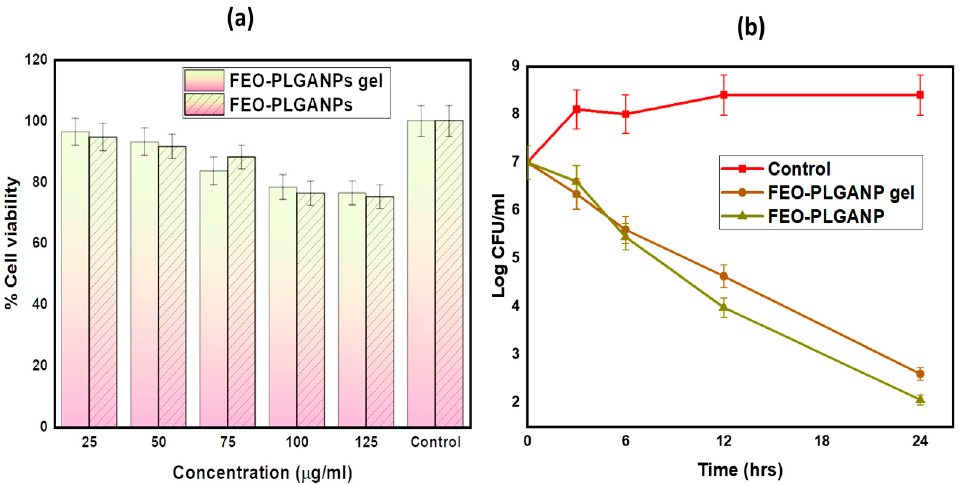
Figure 3. ( a ) Comparative in vitro cell viability assay of FEO–PLGANPs gel and FEO–PLGANPs; ( b ) Time-kill assay of the control, FEO–PLGANPs gel and FEO–PLGANPs. ( b ) Time-kill assay of the control, FEO–PLGANPs gel and FEO–PLGANPs.